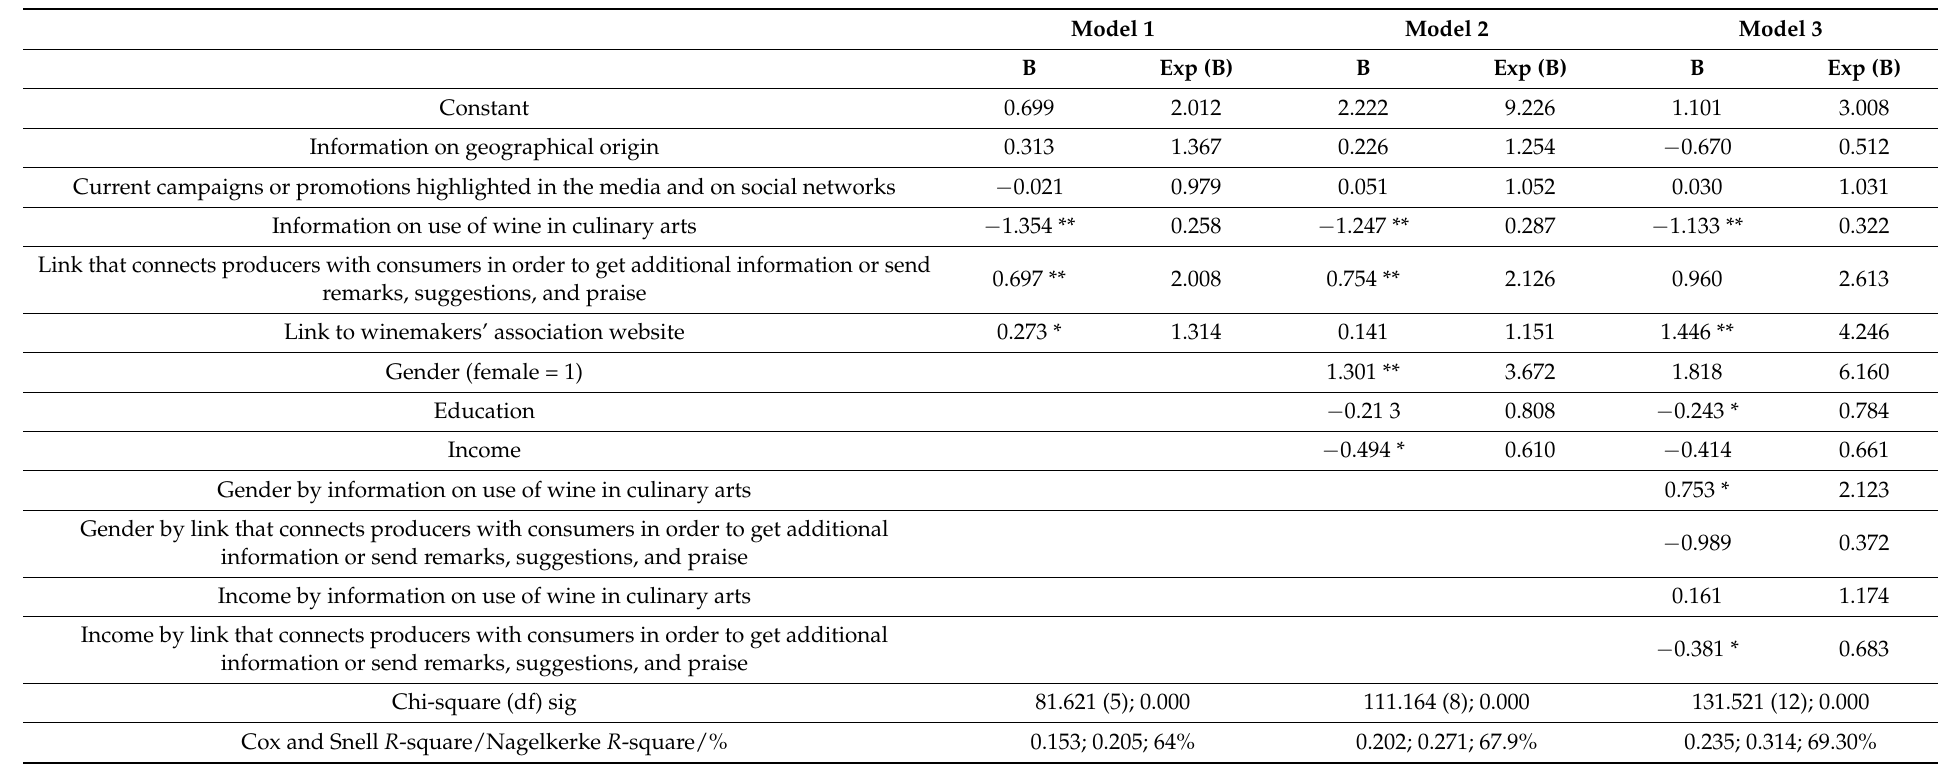
Table 4. Logistic regression for older